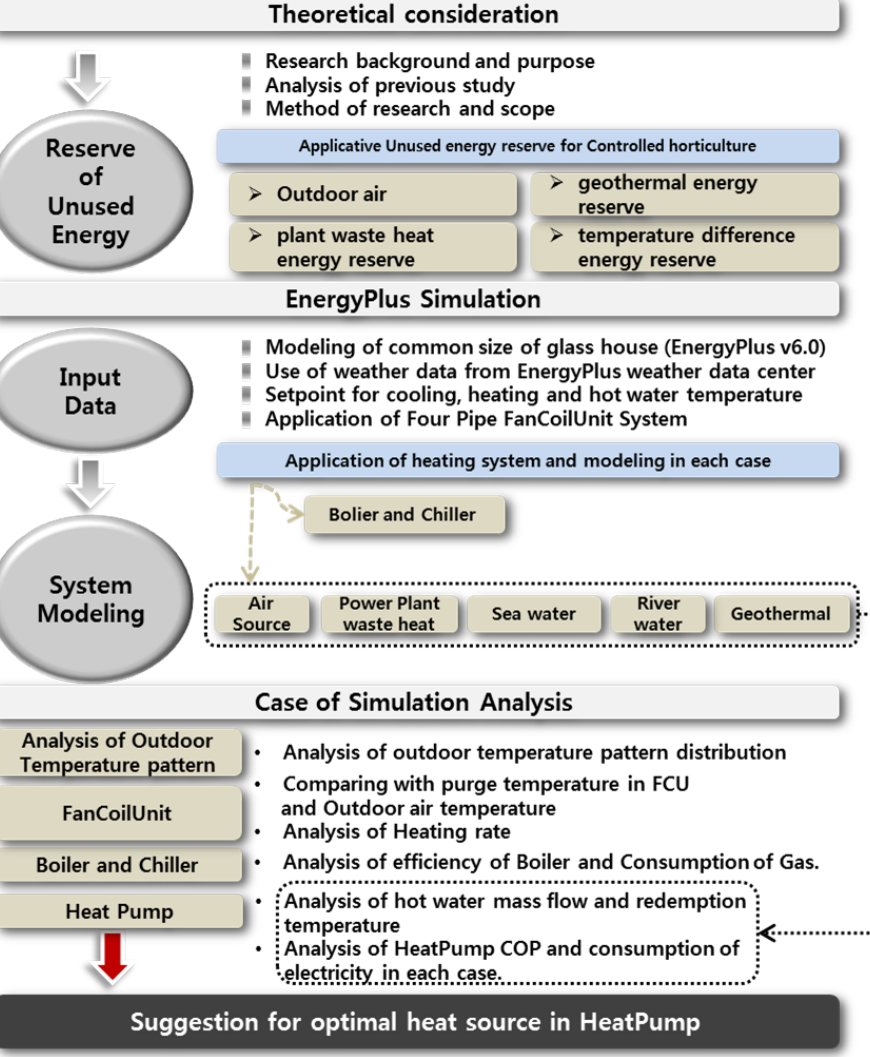
Figure 1. Study flow